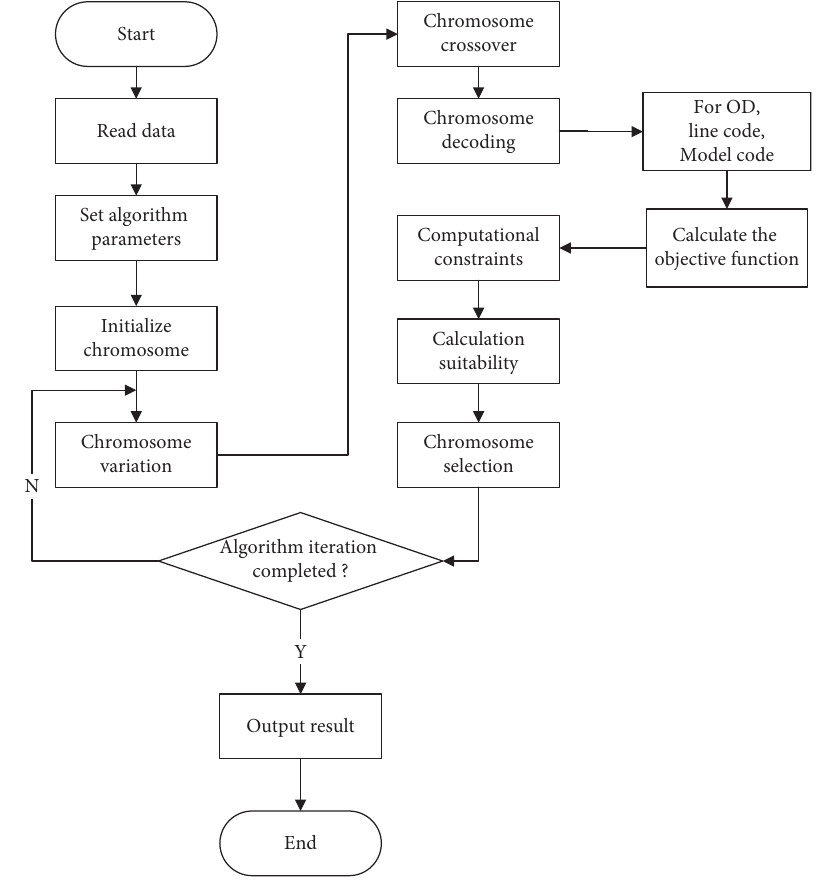
Figure 3: Genetic algorithm solving process.